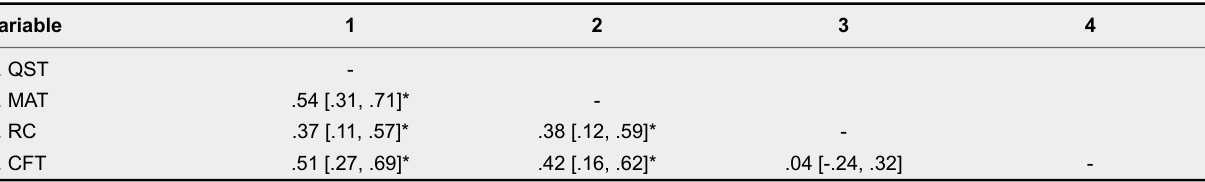
Correlations [95% confidence intervals] Between Performances in all Tests